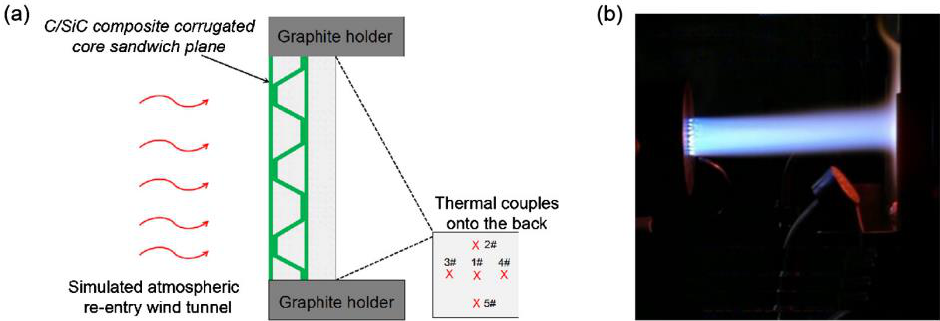
Figure 23. Schematic diagram of the quartz lamp heating test.